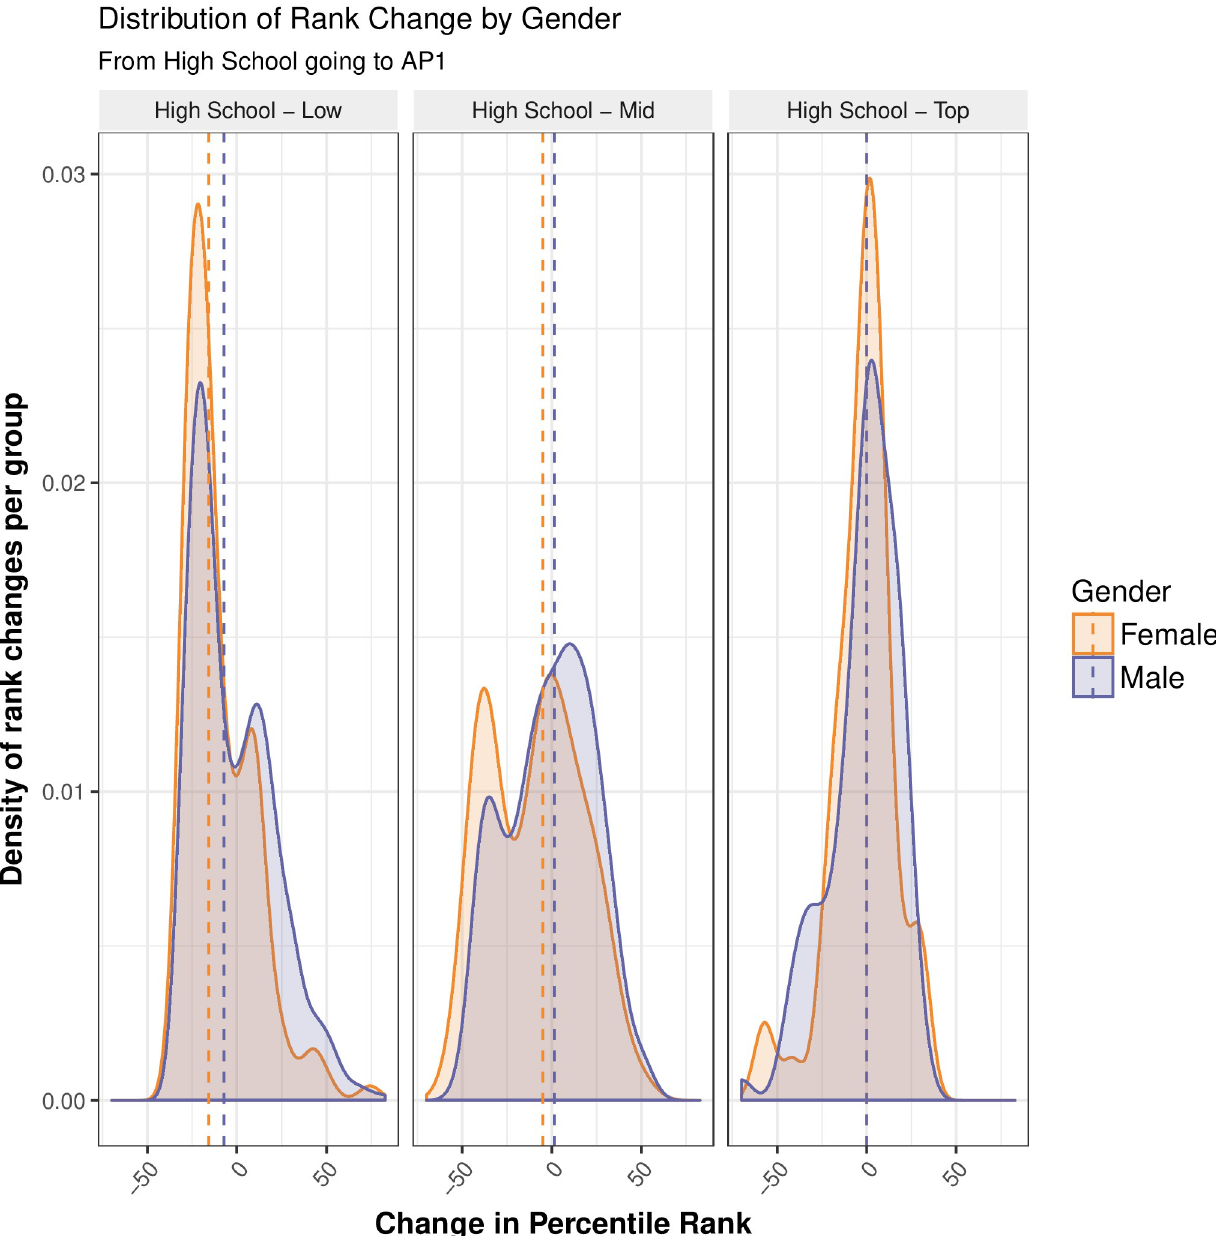
Fig 6. Distribution of rank change by gender and high school achievement group. The above density plots show the distribution of rank change going from high school to Advancing Physics 1 (AP1). Purple represents the distribution of rank changes for male students, while orange represents female students. The dotted vertical line show the median rank change per group. On average, low achieving female students went down 6 ranks compared to their male counterparts, while middle achieving female students went down 9 ranks relative to their male counterparts. There was no significant gender difference in rank change for top